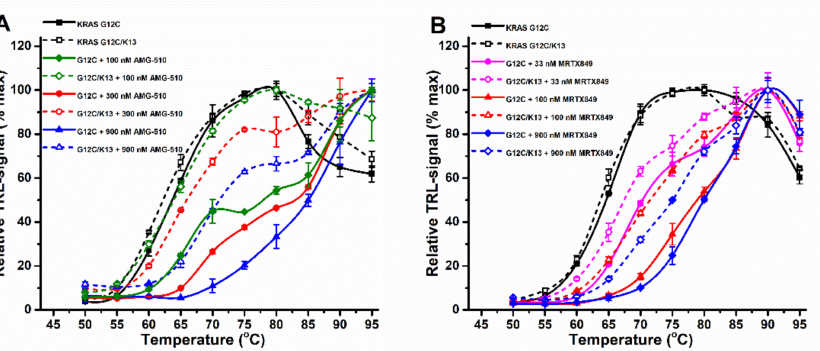
Figure 6. Competitive thermal shift assay for visualizing inhibitors having no direct effect on KRAS thermal stability. ( A ) In the absence of K13 (solid), 50 nM KRAS G12C (black) was significantly stabilized by 100 (green), 300 (red), or 900 nM (blue) AMG-510. In the presence of K13 (dashed), KRAS G12C was not affected, but the stabilizing effect of AMG-510 could be totally or partially reversed. ( B ) In the absence of K13 (solid), 50 nM KRAS G12C (black) was significantly stabilized by 33 (magenta), 100 (red), or 900 nM (blue) MRTX849. In the presence of K13 (dashed), KRAS G12C was not affected, but the stabilizing effect of MRTX849 could be partially reversed. Data represent mean ± SD ( n =